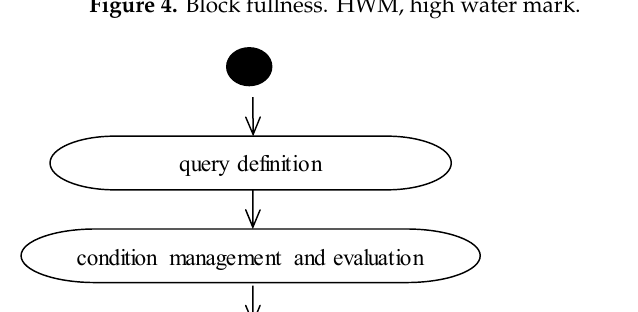
Figure 4. Block fullness. HWM, high water mark.